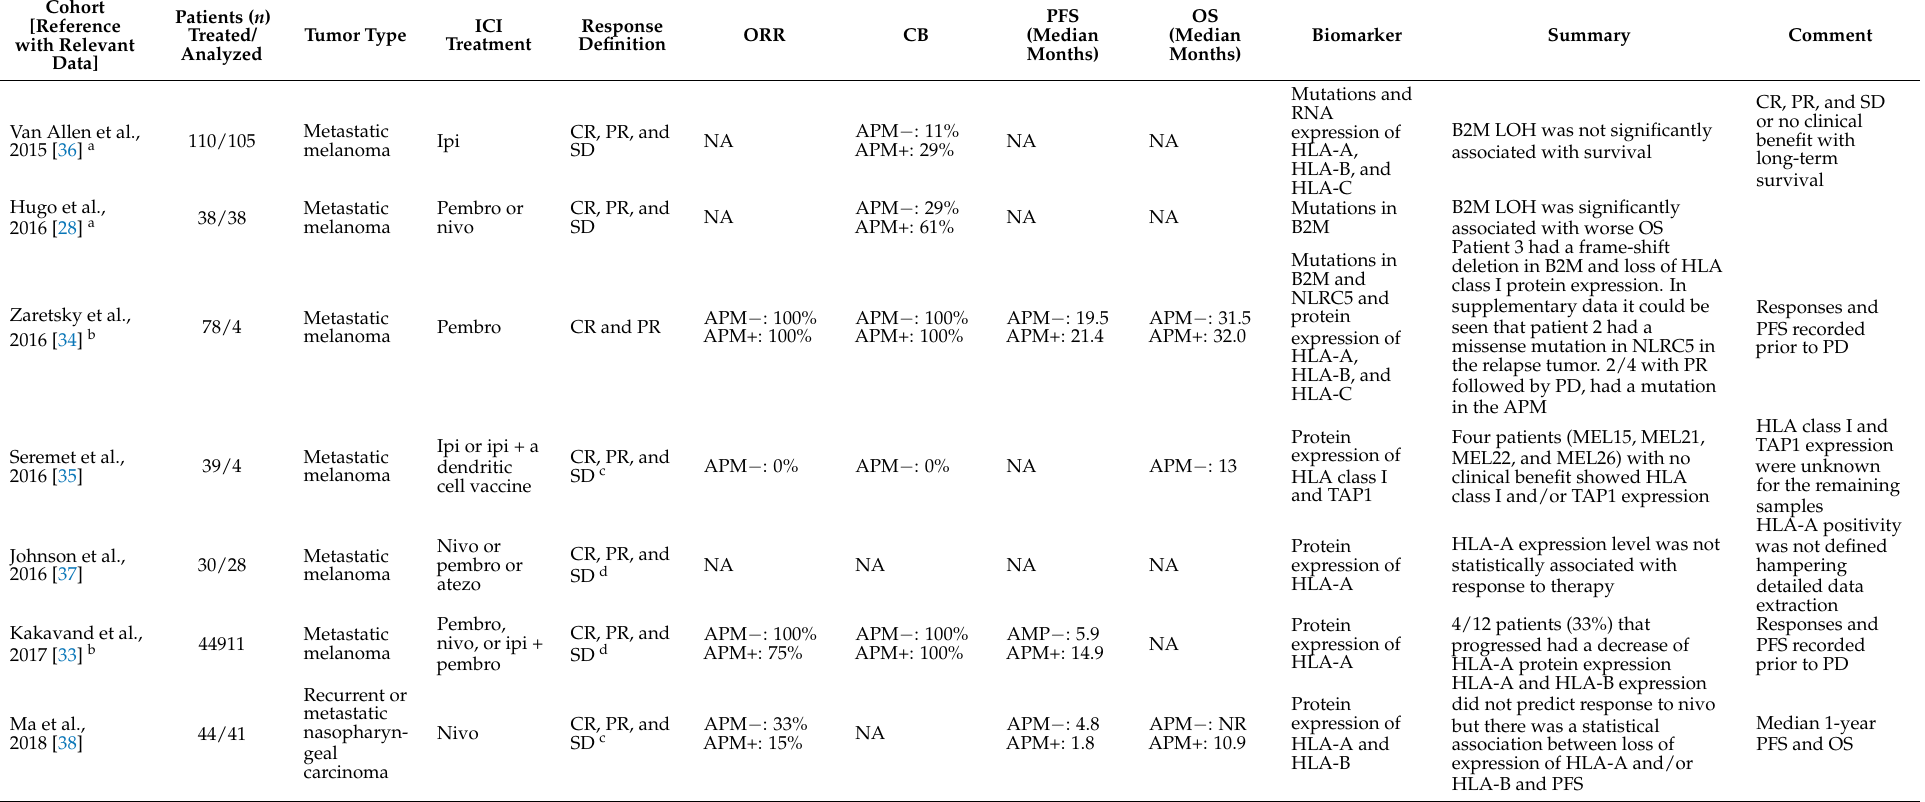
Table 1. Clinical response to ICI therapy in relation to defects in the APM (cohort